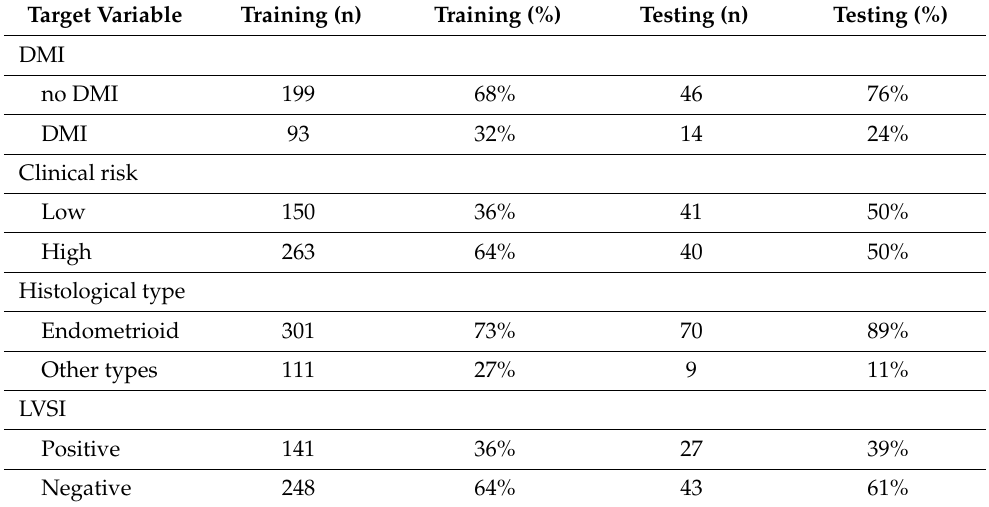
Table 1. Training and testing data for target/response variables. Four binary target/response variables, i.e., DMI, clinical risk, histological type, and presence of LVSI were included as rows; the col- umns of the training and testing show the number of subjects used in the machine learning classifi- cation study.